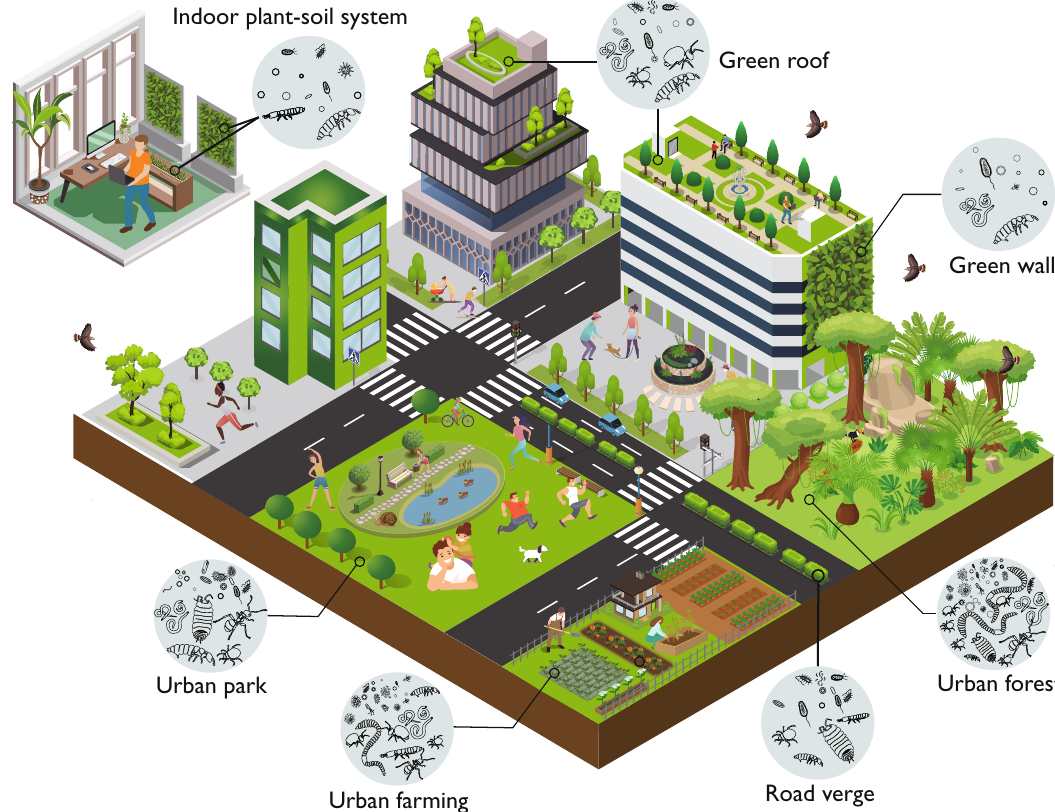
Fig. 1 Soil is a primary reservoir of biodiversity in urban ecosystems. Human-caused disturbance and loss of natural habitats greatly affect urban soil biodiversity. However, there are multiple mitigation options (e.g., green roofs and walls, indoor habitats, diversi fi ed and restored parks) to provide soil habitat to increase soil biodiversity in indoor and outdoor